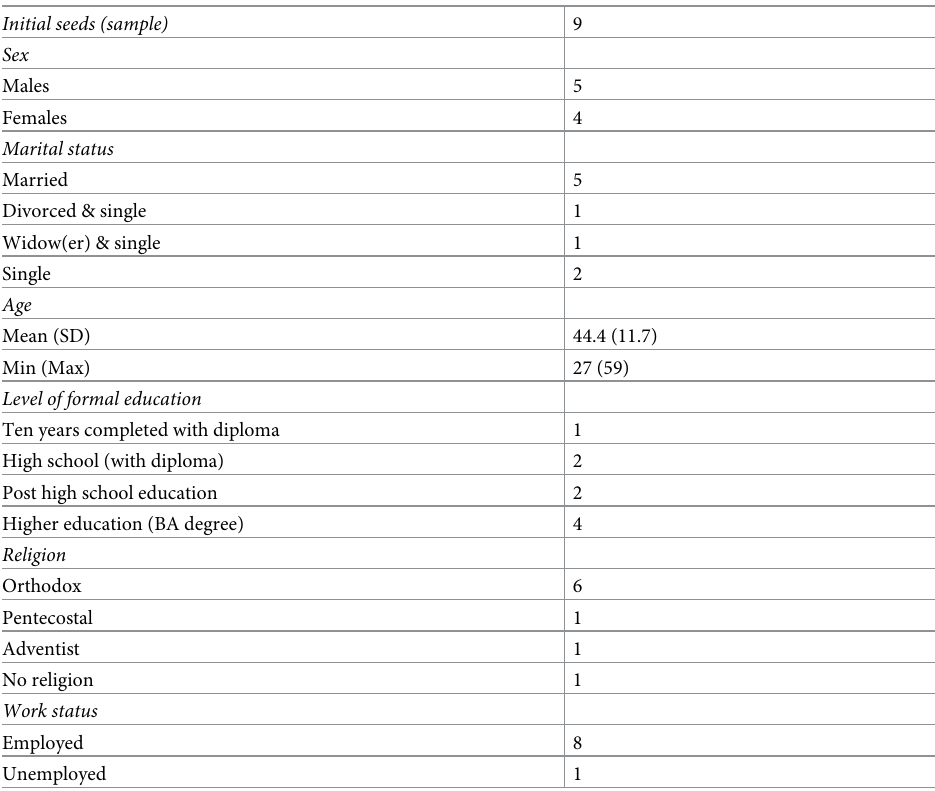
Table 2. The demographic profile of the initial subjects in the sample (the